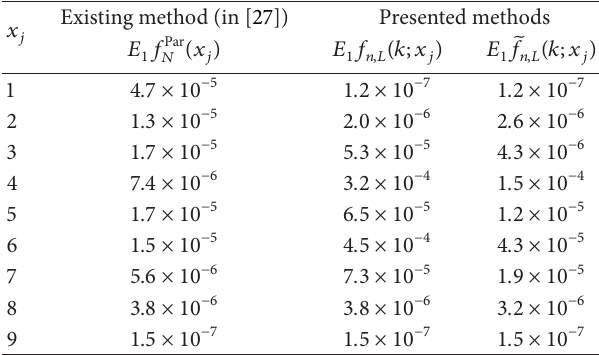
Table 4: Relative errors for the first derivative 𝑓 󸀠 (𝑥)